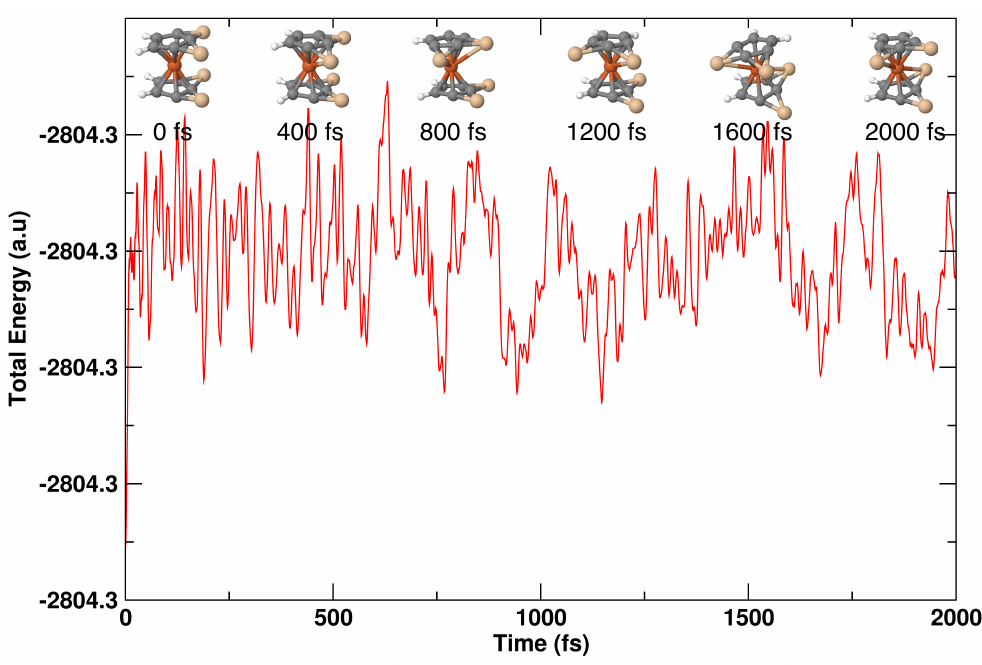
5 -C 2 + obtained from the AIMD 2 - η 5 H 2 ) 2 ]